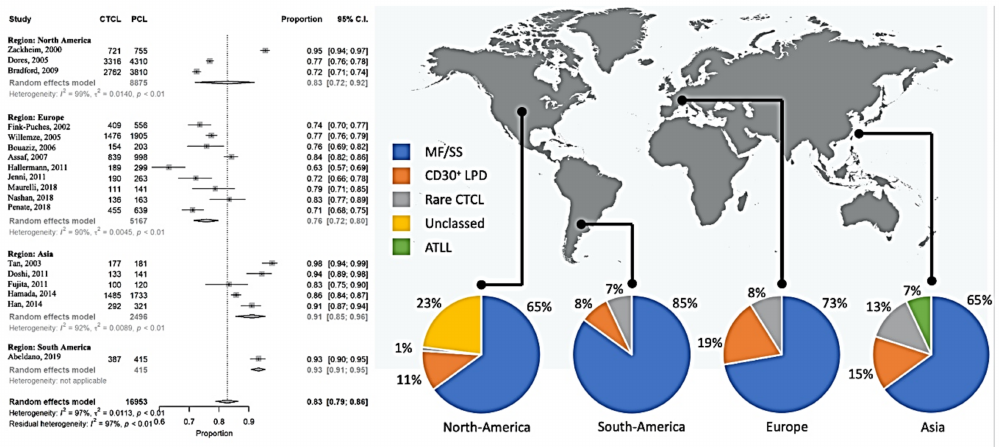
Figure 2. Meta-analysis of the proportion of CTCL compared to all primary cutaneous lymphomas and overview of the